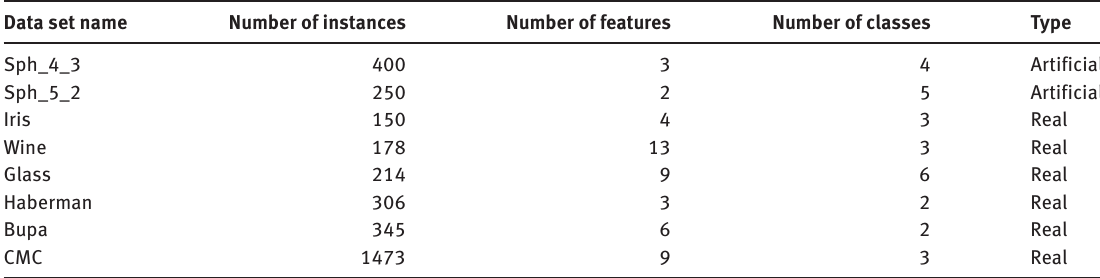
Table 1: Main Characteristics of Data Sets